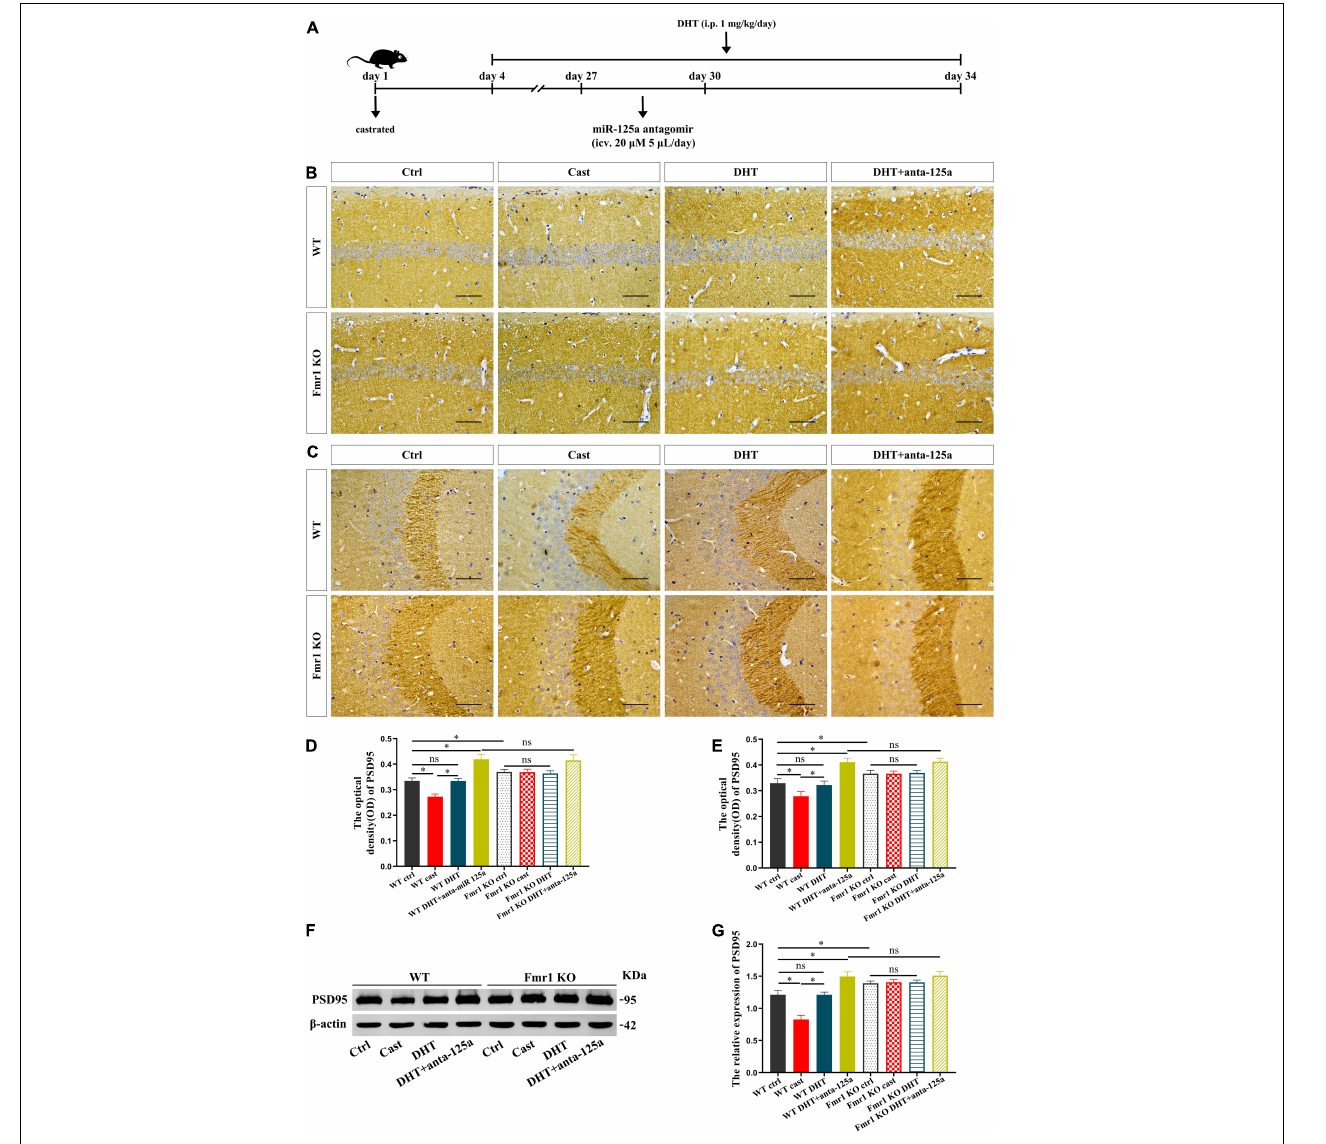
FIGURE 7 | FMRP and miR-125a associatively regulate the effects of DHT on PSD95 protein in Fmr1 KO mice. (A) Experimental procedure. Mice were treated with castration and DHT (i.p. 1 mg/kg/day), and miR-125a antagomir (icv. 20 µ m, 5 µ L/day). (B,C) Immunohistochemical staining for PSD95 of hippocampal CA1 and CA3 pyramidal neurons induced by DHT pre-treated with miR-125a antagomir or NC antagomir. (D,E) Graphs show the average optical density values of PSD95 protein of hippocampal CA1 and CA3 pyramidal neurons. (F) Western blotting for PSD95 of hippocampus induced by DHT pre-treated with miR-125a antagomir or NC antagomir. (G) Graphs show the relative expression of PSD95 protein of the hippocampus. Scale bars = 50 µ m (* p < 0.05, n =